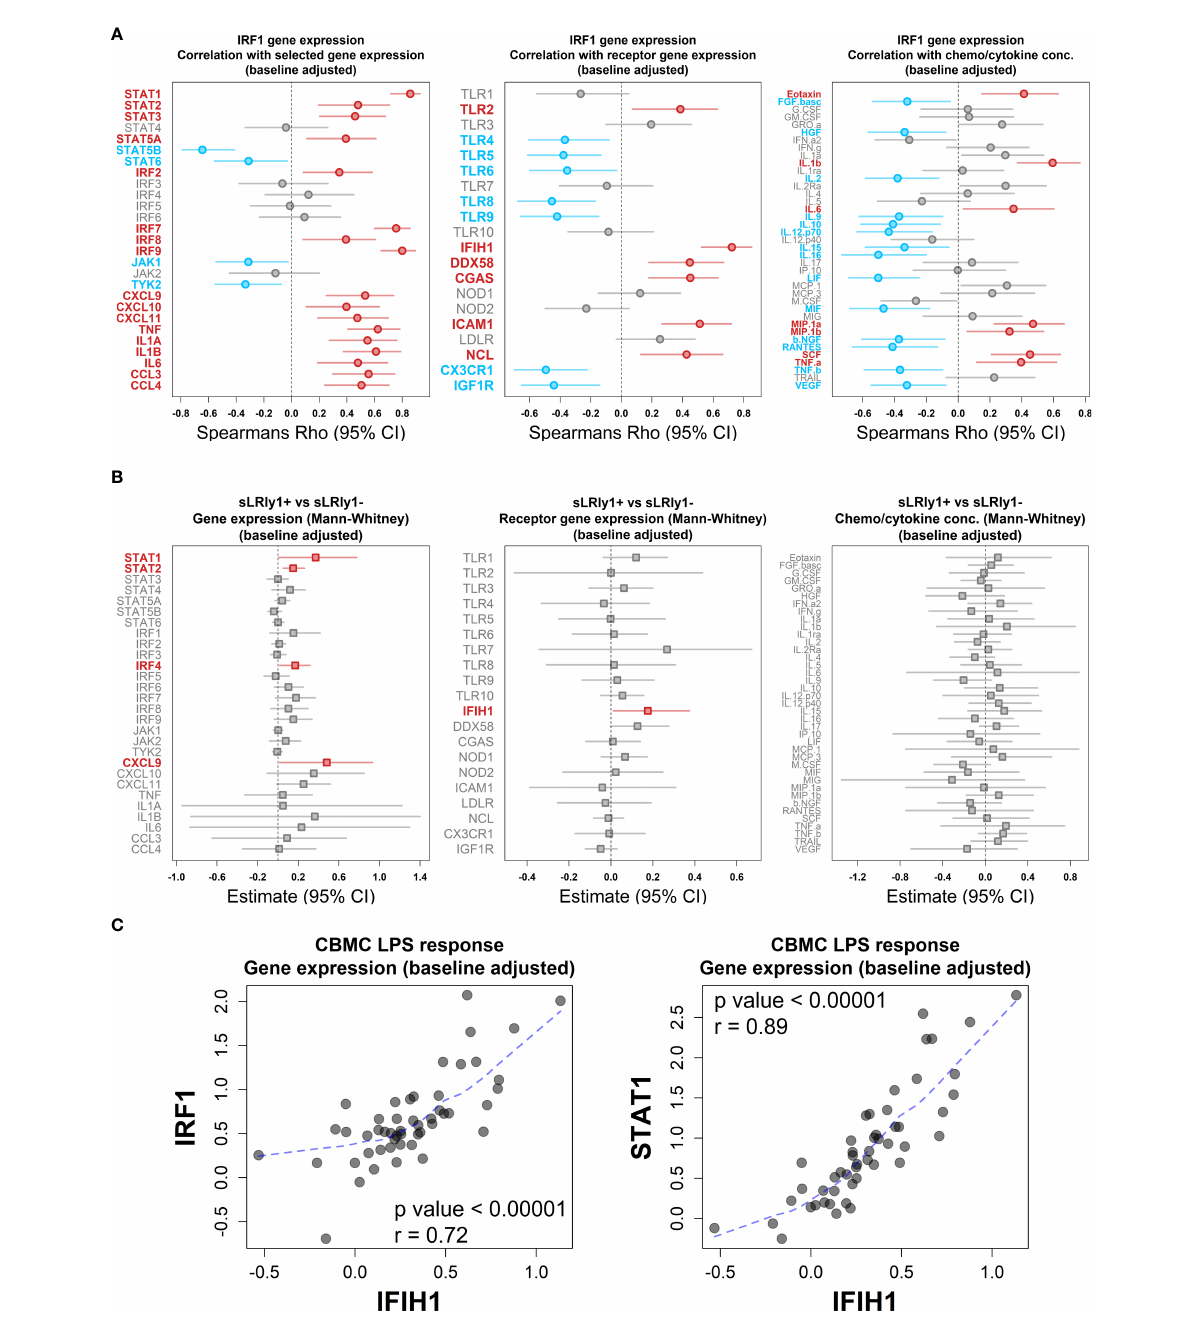
FIGURE 6 LPS-induced IRF1 correlates with key interferon/proin fl ammatory mediators. (A) Plot of the association between LPS-induced IRF1 gene expression with selected IFN and proin fl ammatory gene expression (left), viral-related receptor gene expression (center) and chemo/cytokine protein concentration (right). Data was adjusted with respect to matched unstimulated samples and plots shows Spearman ’ s Rho value (symbol) and 95% CI (bars, 1000 bootstraps); Red and blue data points/labels denote positive and negative correlations, respectively, with a BH-adjusted p value <0.05. (B) Analysis of selected IFN and proin fl ammatory gene expression (left), viral-related receptor gene expression (center) and chemo/cytokine protein concentration (right) with respect to sLRI susceptibility in the fi rst year of life. Data was adjusted with respect to matched unstimulated samples and plots show the Mann-Whitney U test estimates and 95% CIs for CBMC data of individuals who are susceptible compared to resistant to sLRIs in infancy. Red data points/labels indicate increased expression with a p value < 0.05. (C) Spearman ’ s correlation and associated p value between IFIH1 (x-axis) and IRF1/ STAT1 (y-axis) gene expression from CBMC samples stimulated with LPS (n=50). Data was adjusted with respect to matched unstimulated samples. Dashed blue line represents a loess fi t of the